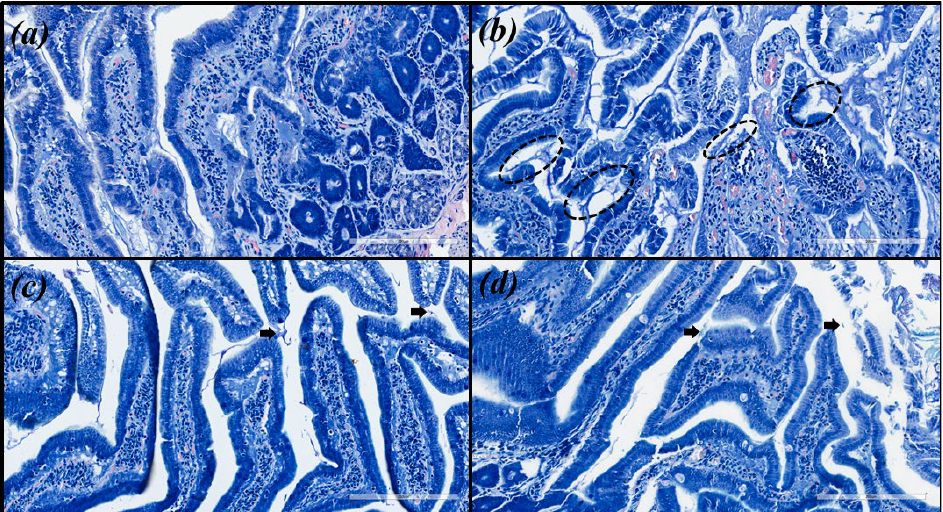
Figure 4. Images of the biological tissue (antrum-pyloric) of rats stained with modified Giemsa. ( a ) Uninfected group. ( b ) Infected group—black circles indicate stained H. pylori (blue) that are attached to the gastric epithelial cells (moderated density). ( c ) Group infected and treated with triple therapy (amoxicillin 50.0 mg/kg, clarithromycin 25.0 mg/kg, and omeprazole 20.0 mg/kg)—the arrows point to occasionally stained H. pylori (mild density). ( d ) Group infected and treated with 300 mg/kg of crude hydroalcoholic extract of Brazilian red propolis—the arrow point to occasionally stained H. pylori (mild density).